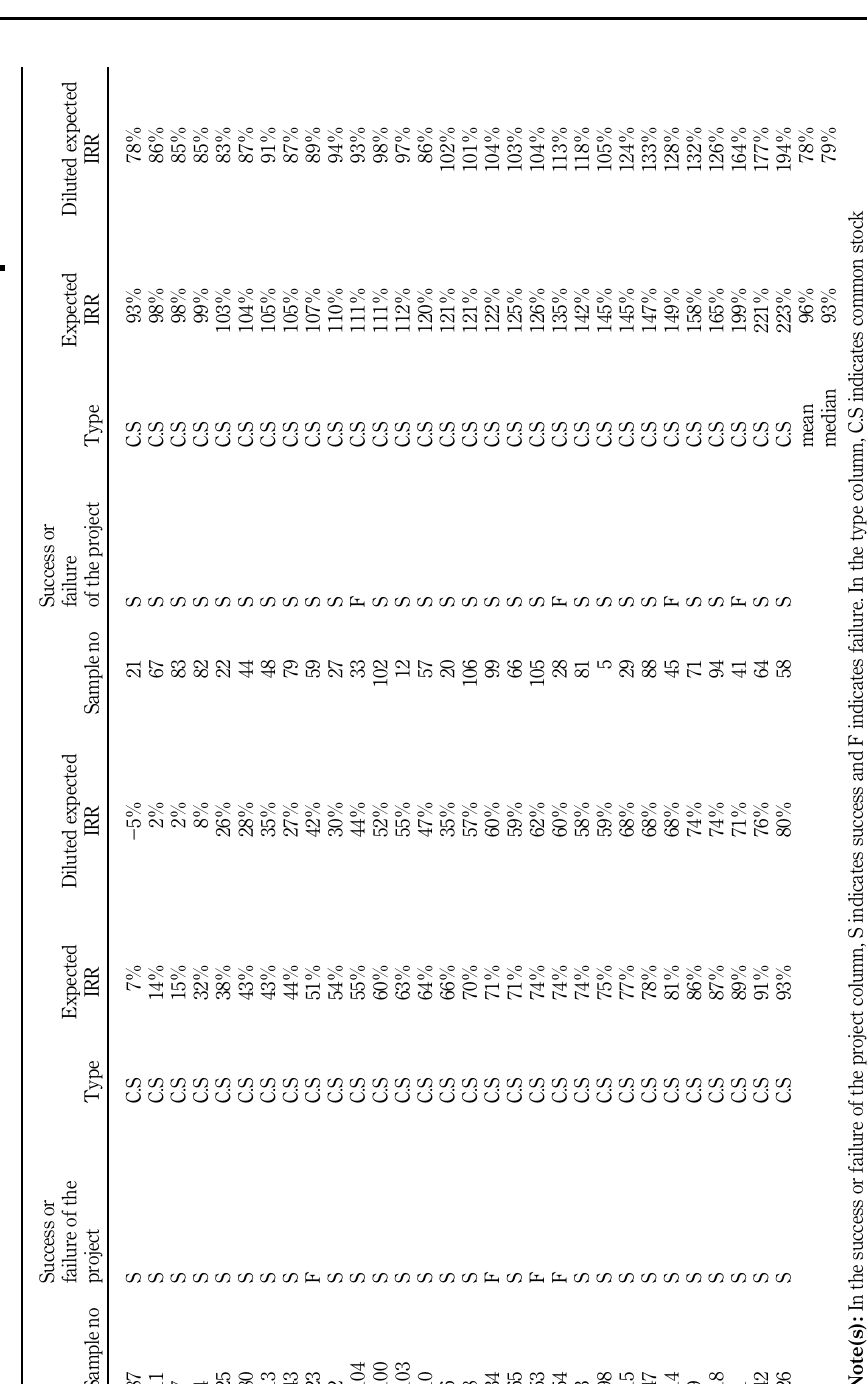
Table 7. Expected IRRs of